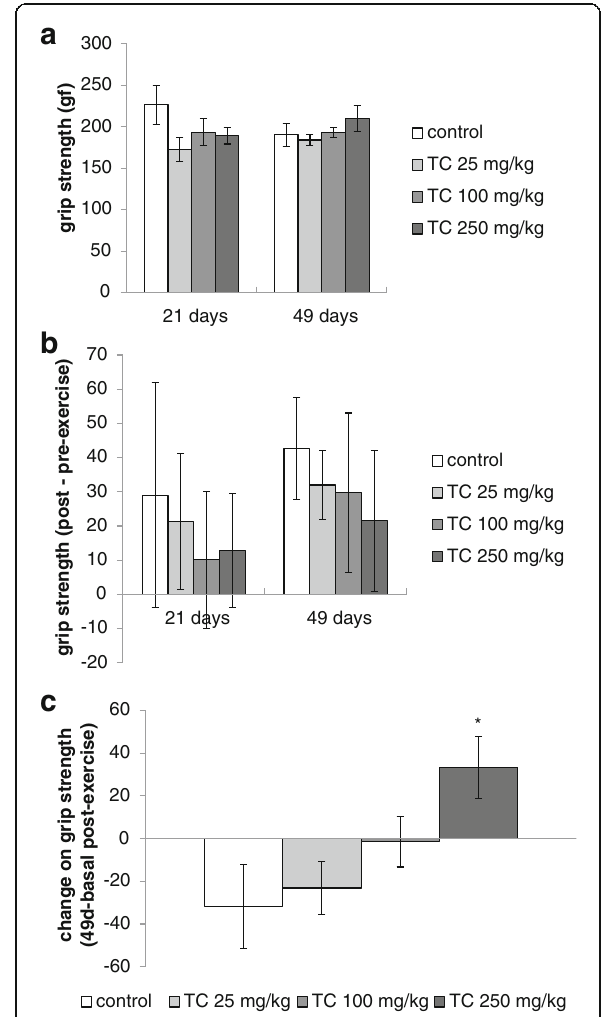
Fig. 3 a Post exercise grip strength, b difference of grip strength (before - post-exercise) and ( c ) performance change (post-exercise grip strength 49d - basal) of mice chronically treated with Trichilia catigua (TC) hydroalcoholic extract (25, 100 and 250 mg/kg, p.o.) and subjected to the forced exercise on treadmill. The columns and bars express the mean ± SEM ( n = 8 – 10). (*) p < 0.05: statistically different of control group. ANOVA followed by Duncan